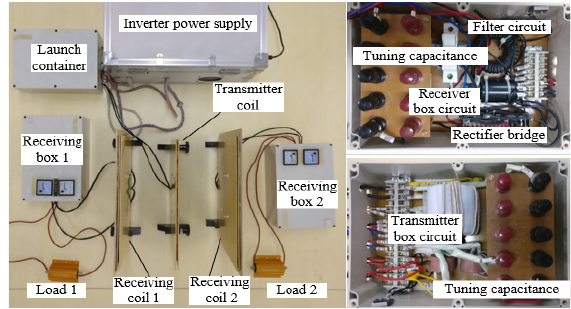
Figure 12. The experiment platform. Table 1. Parameters of the transmitting and receiving coil.